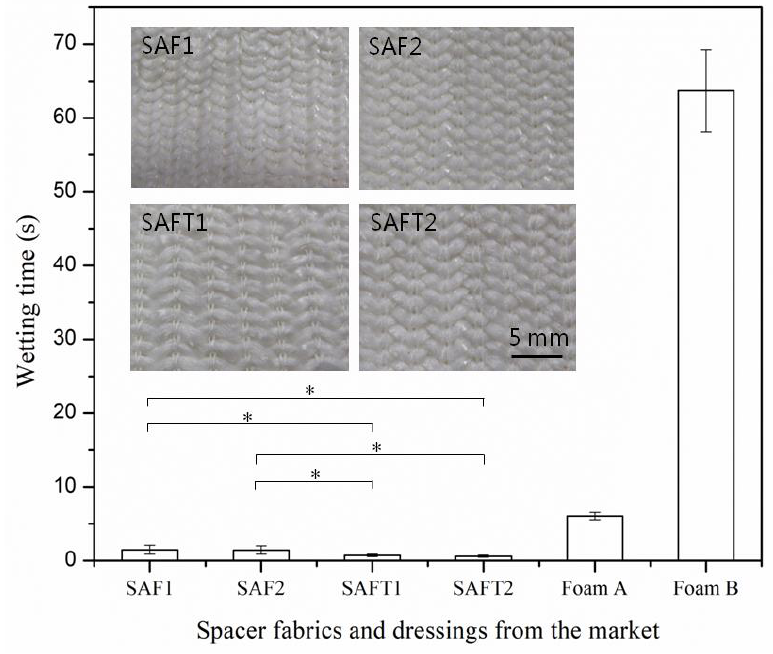
Figure 5. Wetting time of the spacer fabrics and foam dressings from the market. The photos of the surfaces of superabsorbent spacer fabrics are shown to visualize their difference. * p <